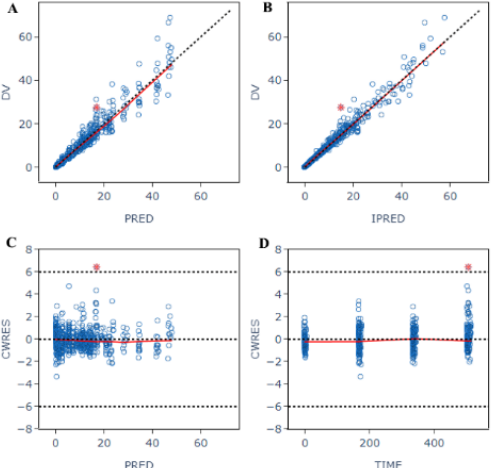
Figure 4. Goodness-of-fit plots for the final pharmacokinetic model. ( A ): Plot of observed concen- trations versus population predictions. ( B ): Plot of observations versus individual predictions. ( C ): Conditional weighted residual versus population predictions. ( D ): Conditional weighted residual versus time. The open circles show observations. The red line shows smooth fitting for observations.